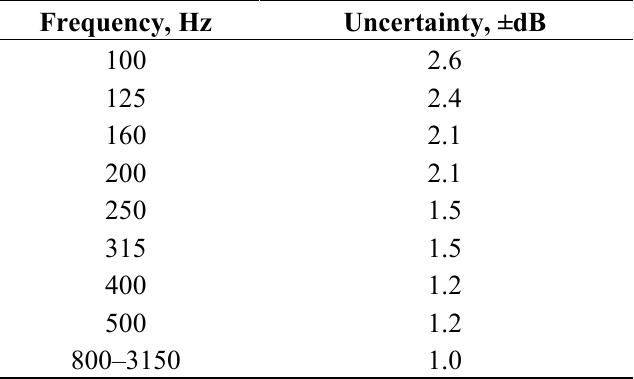
Table 2. Experimental test measurement